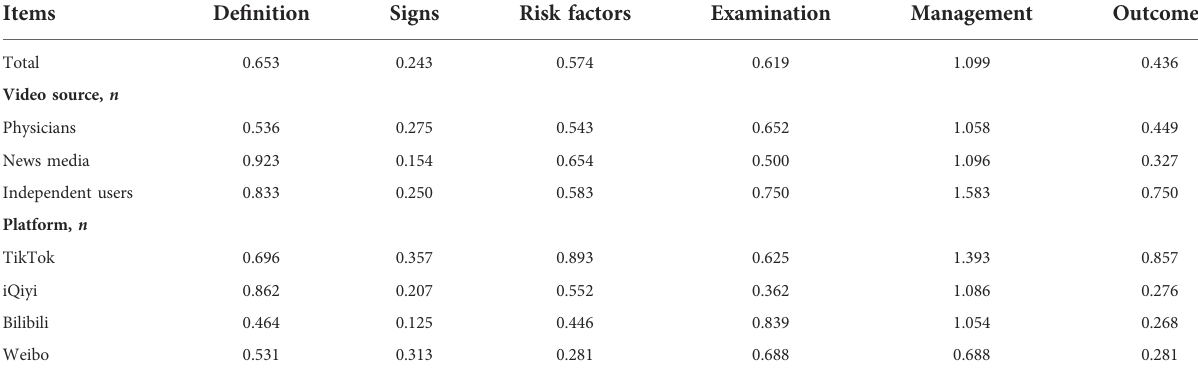
TABLE 5 Hexagonal radar charts of the understudied videos.